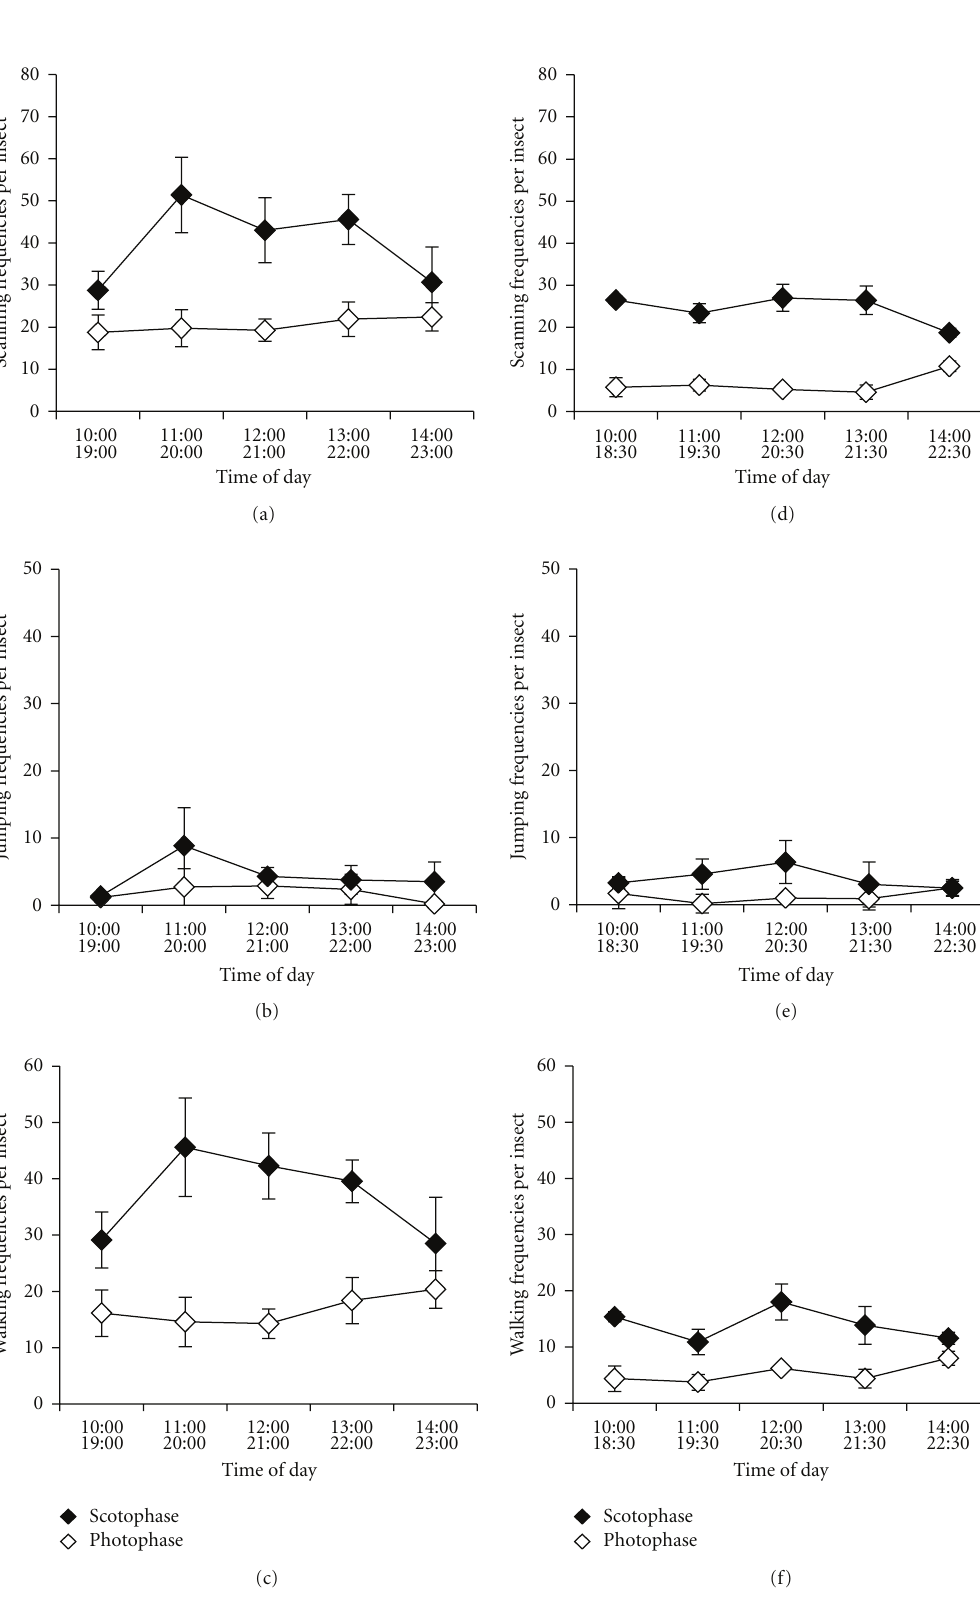
Figure 3: Activity of mature field-collected ((a)–(c)) and laboratory-reared ((d)–(f)) solitarious females. Bars represent standard errors ( ± SE); N = 80 insects used for each of the three